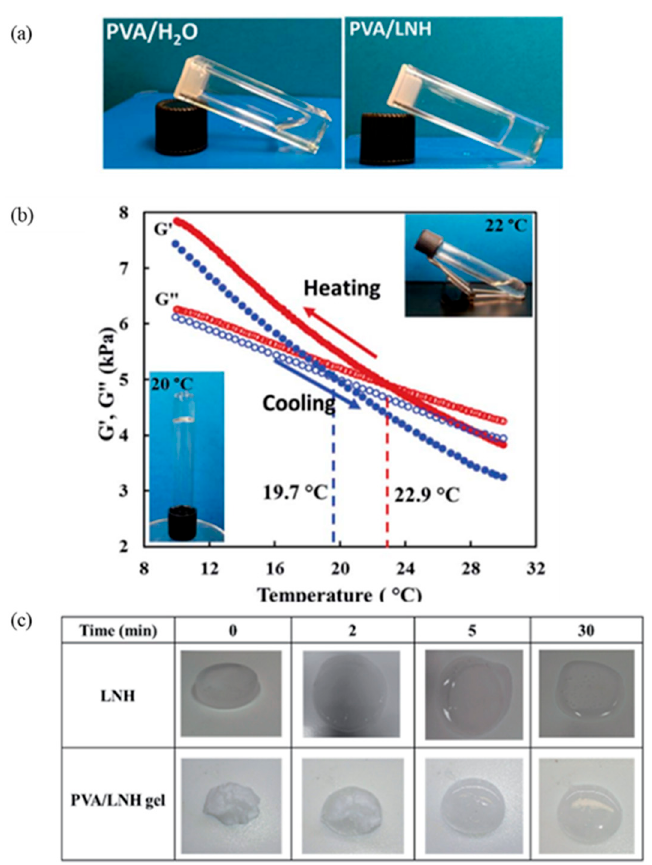
Figure 8. ( a ) Photographic view of water + PVA and LNH + PVA samples; ( b ) heating and cooling curves; ( c ) melting of LNH with and without PVA [74].